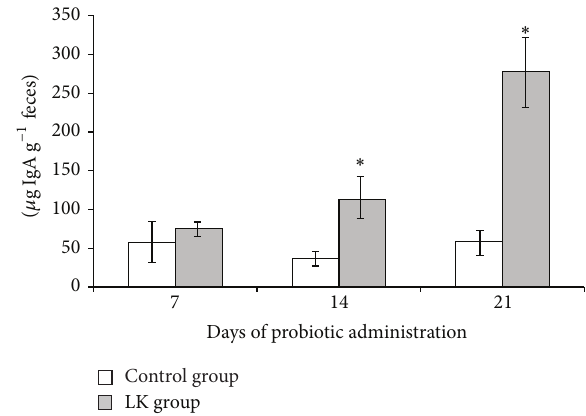
Figure 2: IgA quantification from fecal samples taken on day 7, 14, or 21 from control mice and L. kefiri treated mice (Lk). Results are expressed as mean ± standard deviation. ∗ 𝑃 < 0.05 .